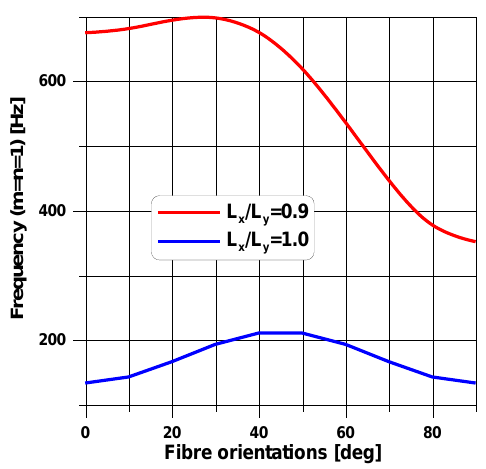
Figure 5. Distributions of eigenfrequencies for angle-ply simply supported (SSSS) plates.